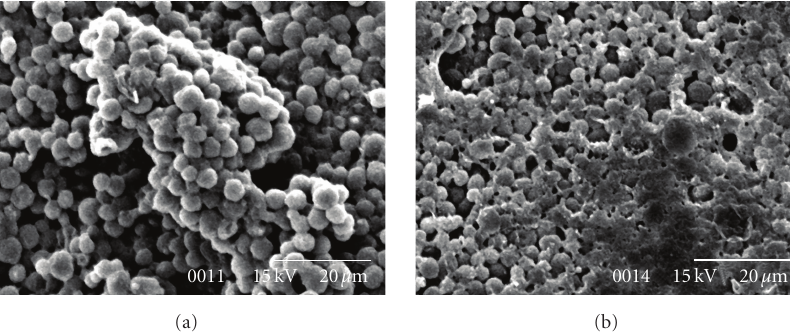
Figure 2: (a) The scanning electron micrographs of the normal bone marrow represented a well-organized compact cellular structures and intracellular association between the stem and stroma in the normal marrow microenvironment. (b) Scanning electron micrographs from the AA bone marrow acquainted an overall scanty and degenerative marrow with no such intertwined stem-stroma structure and distorted cellular components with frequent appearance of apoptic holes.